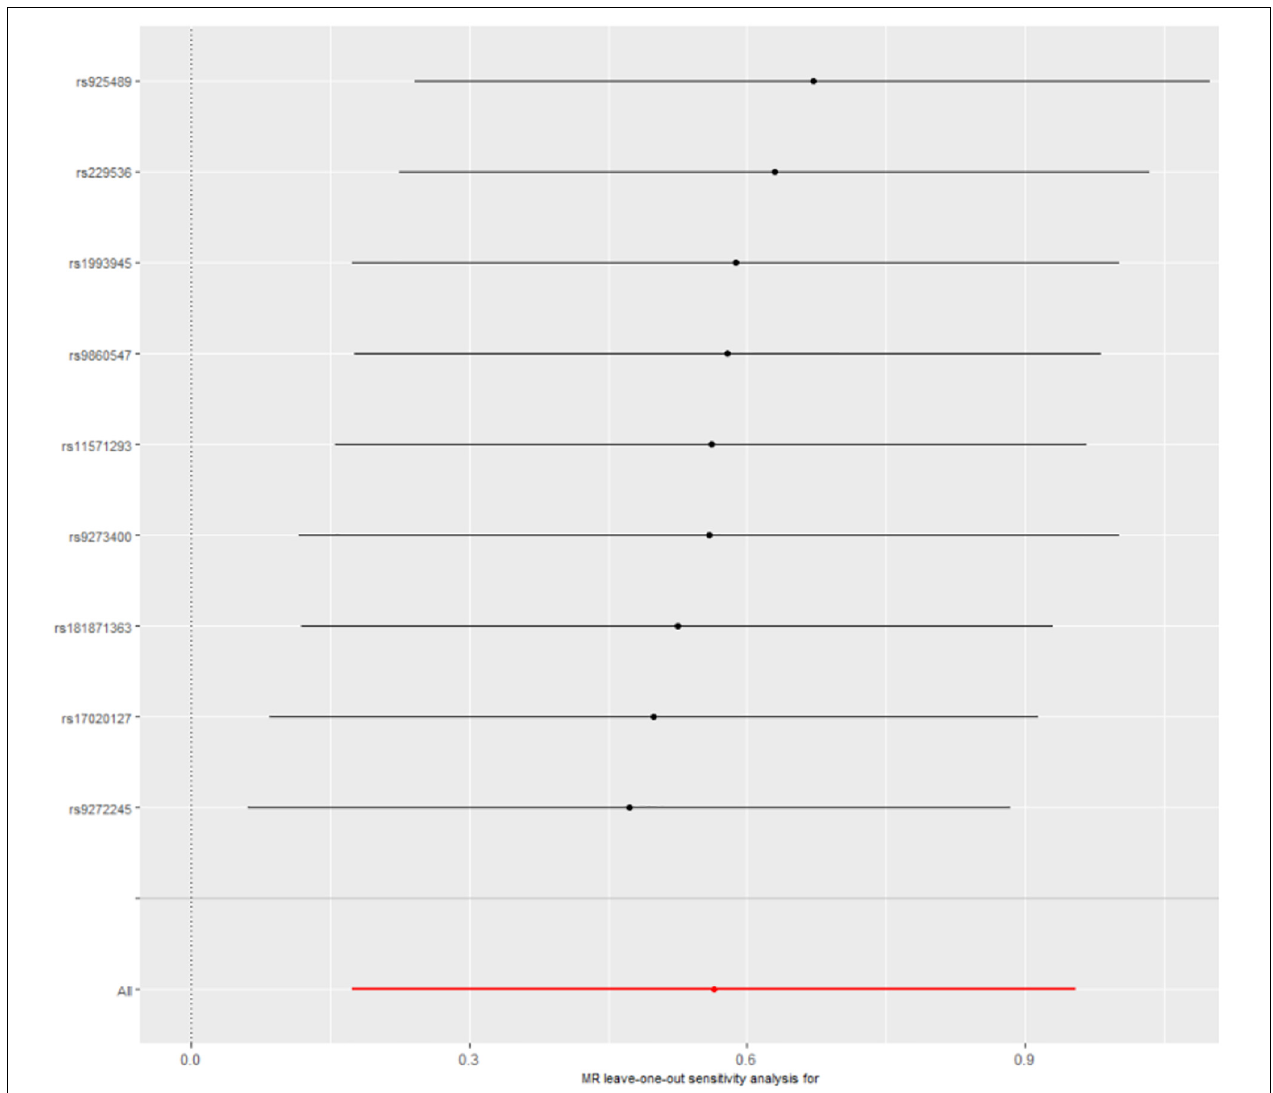
FIGURE 2 | Leave-one-out cross-validation. The red line is the average of all β values after